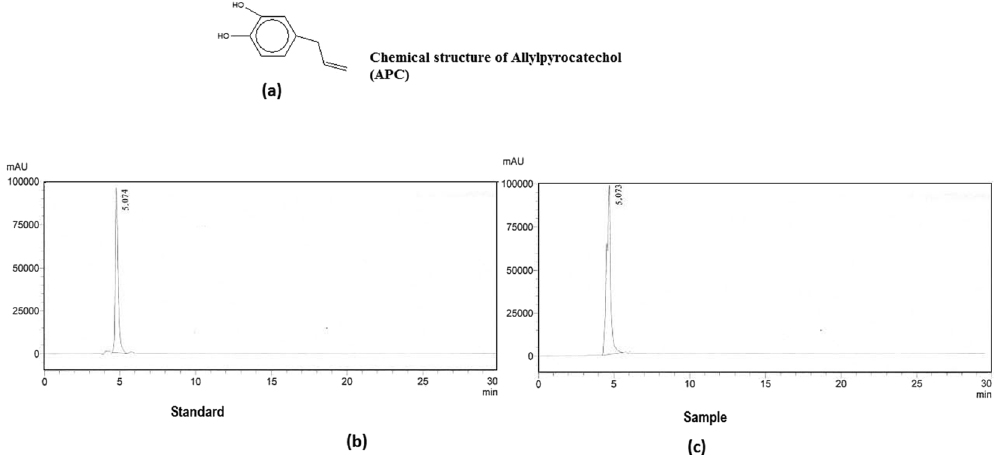
Figure 1. ( a ) Chemical structure of allylpyrocatechol (APC), isolated from Piper betel leaf extract. ( b ) HPLC chromatogram of standard APC with retention time of 5.074 minutes. (c ) HPLC chromatogram of sample APC showing retention time at 5.073 min. It nearly matches with that of the